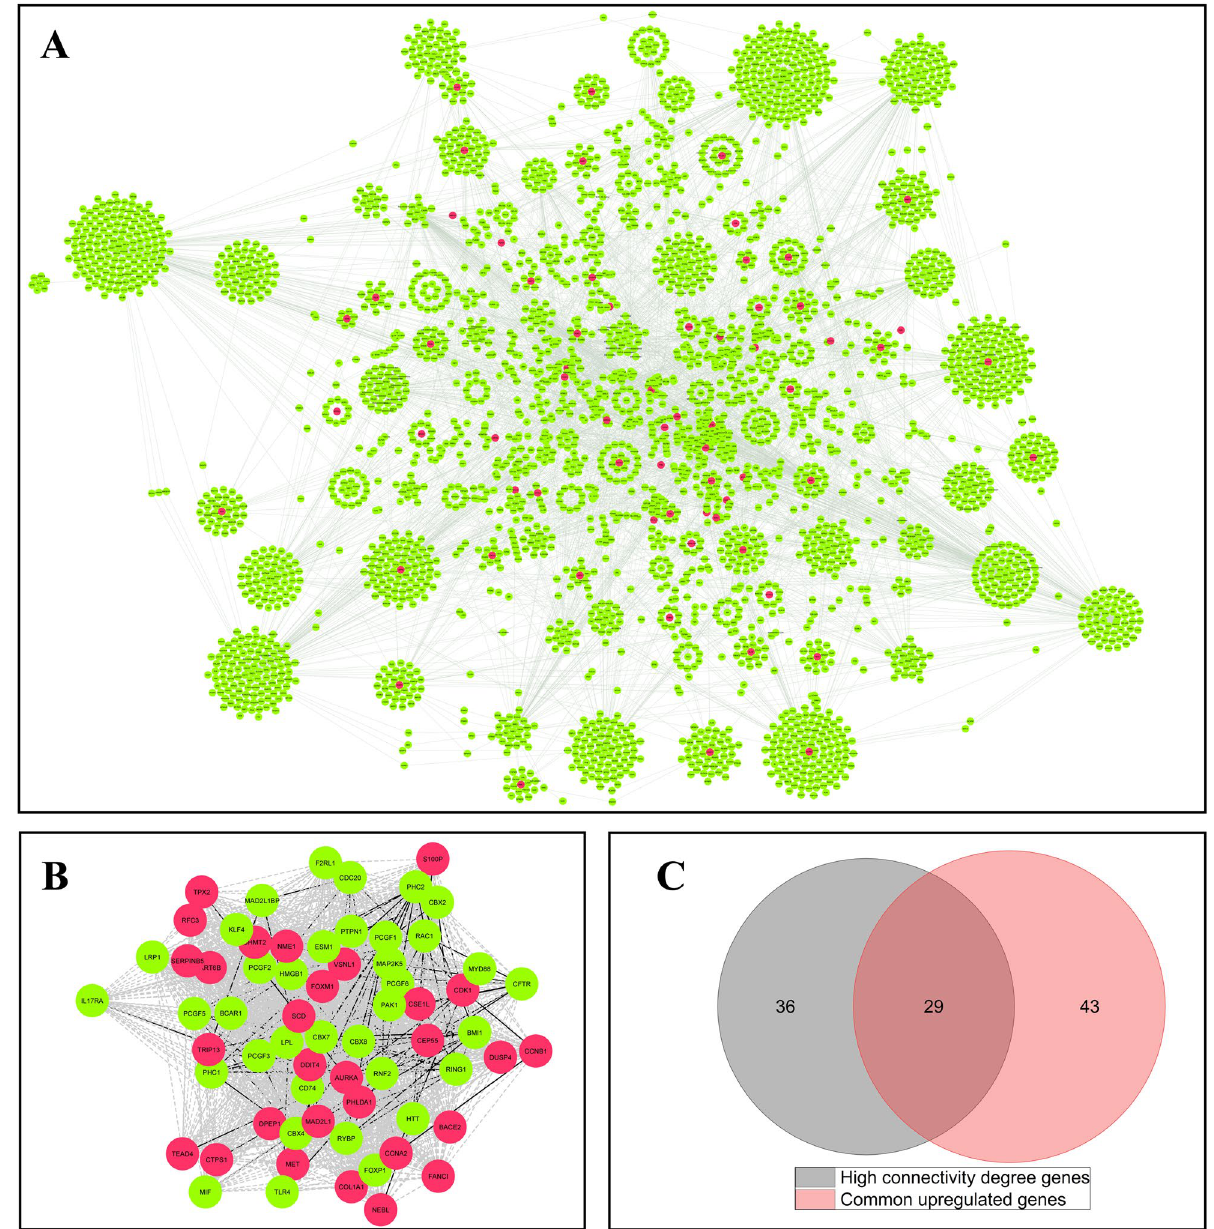
Figure 3. Protein–protein interaction (PPI) analysis based on IMEX database for common upregulated DEGs and detection of hub genes. ( A ) The nodes represent genes and edges represent the interactions between genes. The red nodes signify 72 common upregulated DEGs that are in the interaction with each other and other genes (green nodes). ( B ) PPI network analysis revealed the genes with high connectivity degree (> 75 percentile for the genes with degree > 10) by cyto-Hubba plug-in using Cytoscape software. The dashed lines indicate the connection of genes that are not direct. ( C ) The genes with high connectivity degree that overlapped with common upregulated DEGs were extracted as hub genes by Venn